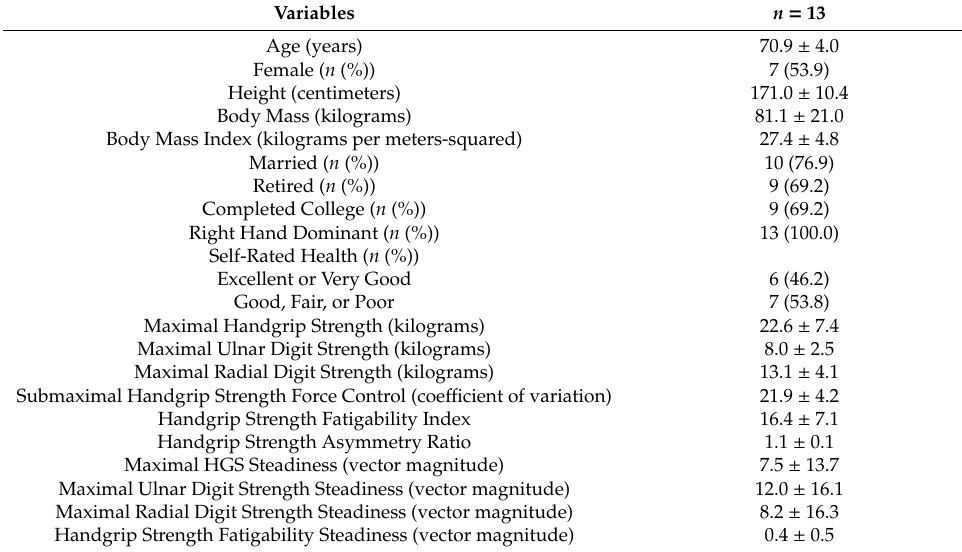
Table 1. Descriptive Characteristics of the Participants.